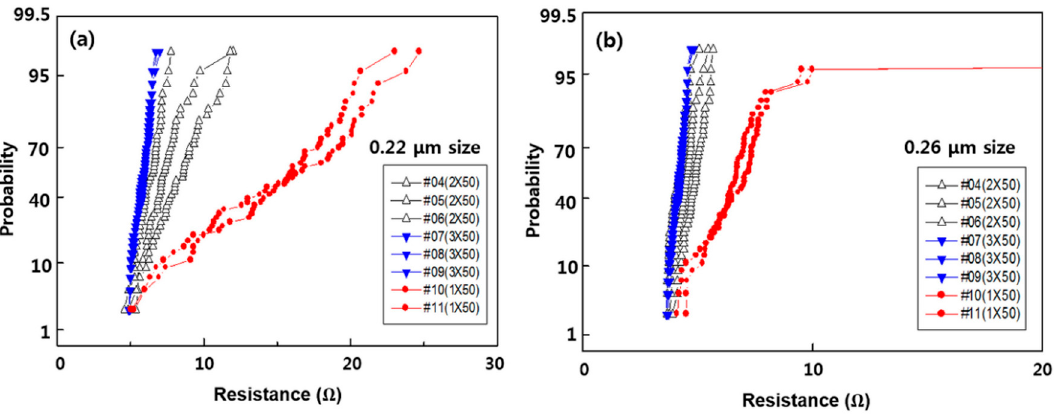
Figure 6. Via resistance according to CVD TiN thickness of ( a ) 0.22 µ m and ( b ) 0.25 µ m in minimum via size pattern.